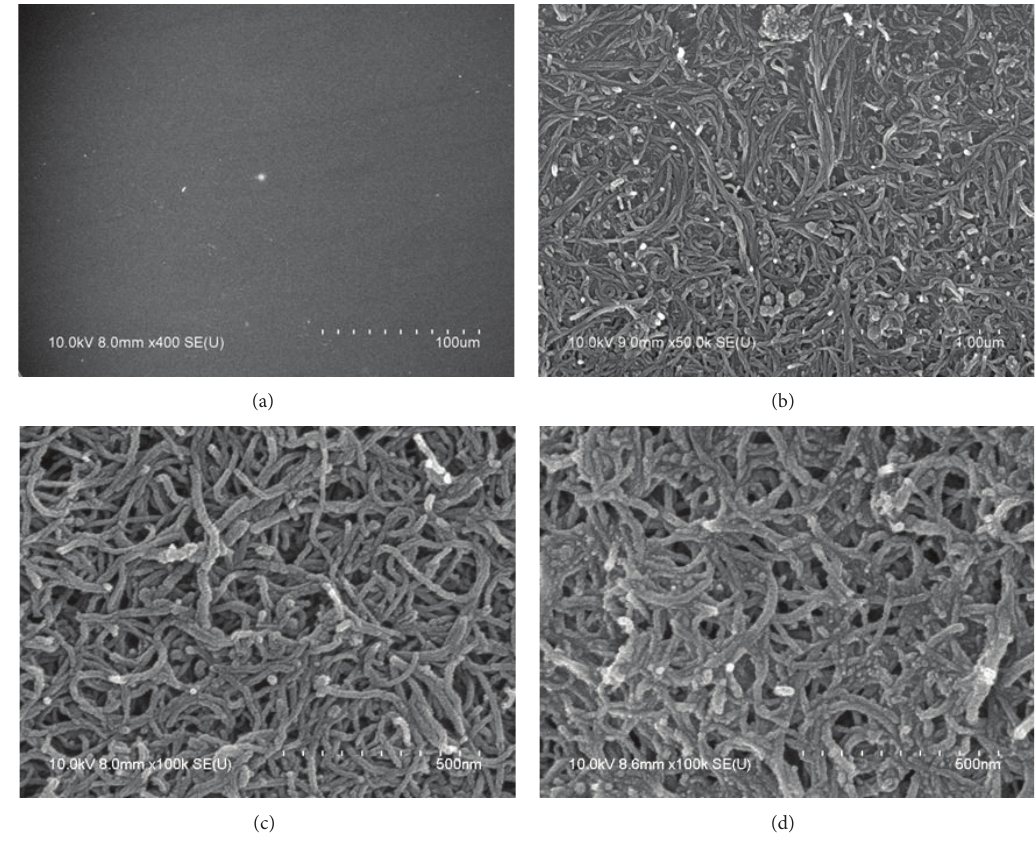
Figure 3: SEM images of the carbon plate as model electrode (a), MWNT-modified electrode (b), COOH/MWNT-modified electrode (c), and AChE-ChOx/COOH/MWNT-modified electrode